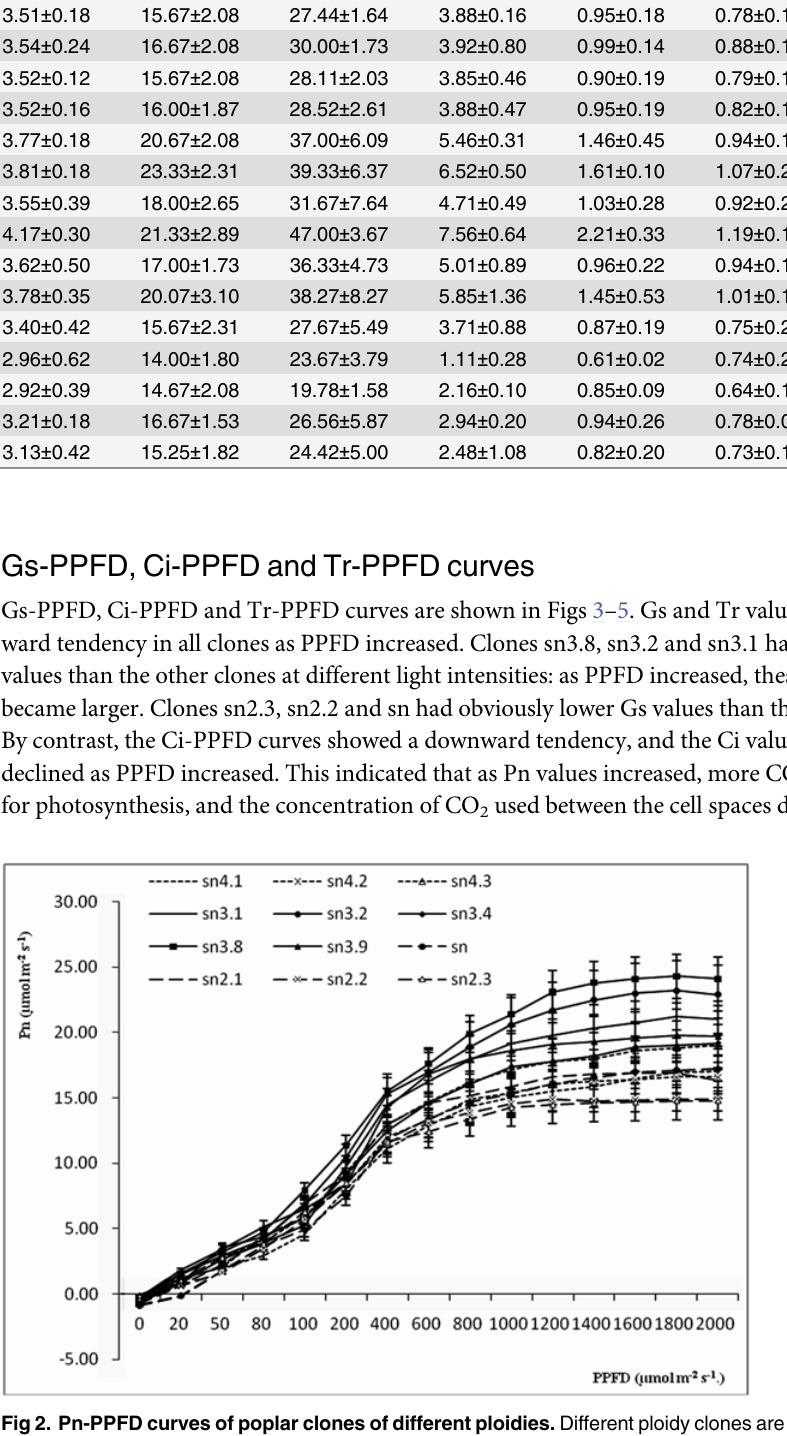
Table 2. Average growth traits for different hybrid clones of different ploidies. Ploidy